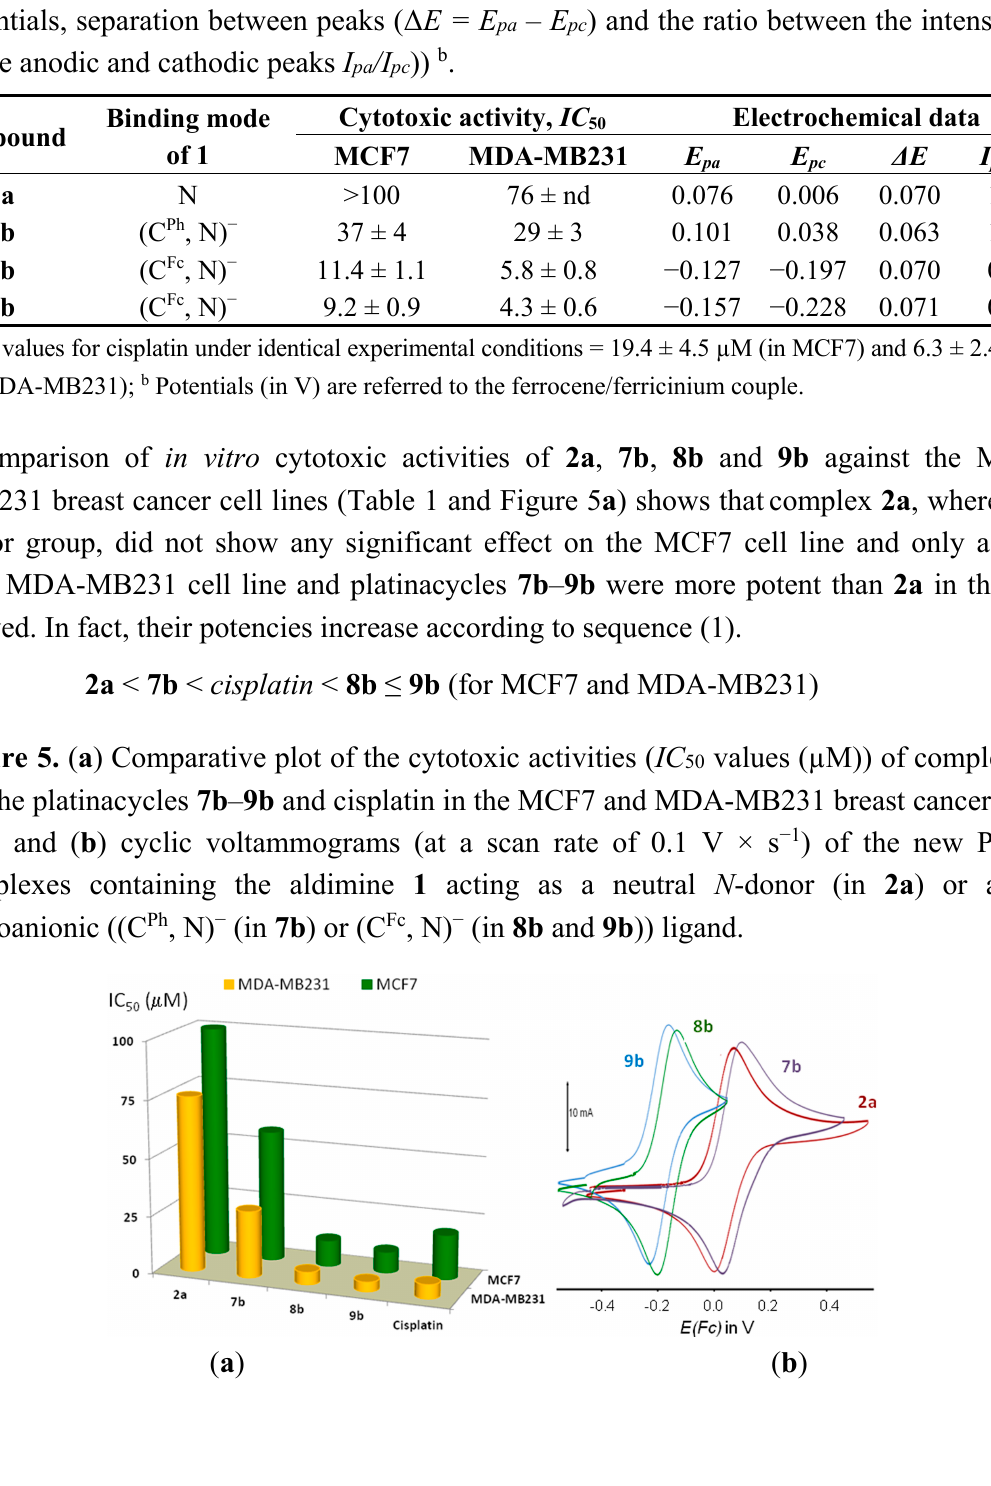
Table 1. Summary of: (a) the cytotoxic activities ( IC 50 (µM)) of compound 2a and the platinacycles 7b – 9b in the MCF7 and MDA-MB231 breast cancer cell lines a ; and (b) their